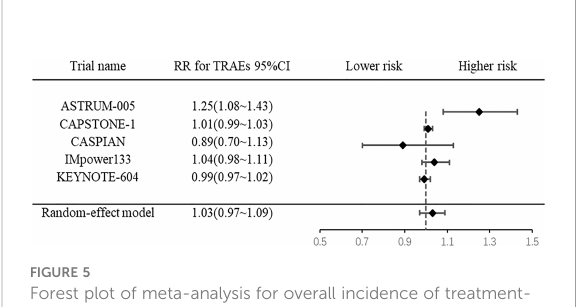
FIGURE 5 Forest plot of meta-analysis for overall incidence of treatment- related adverse